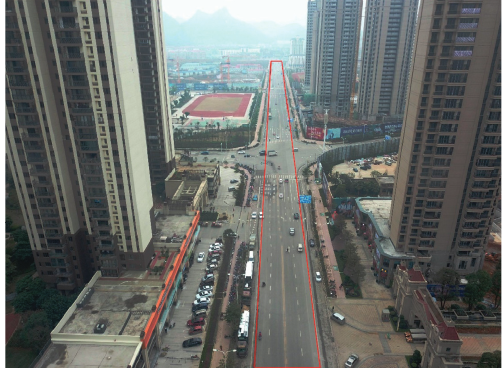
Figure 6: The project location of the tunnel interval.